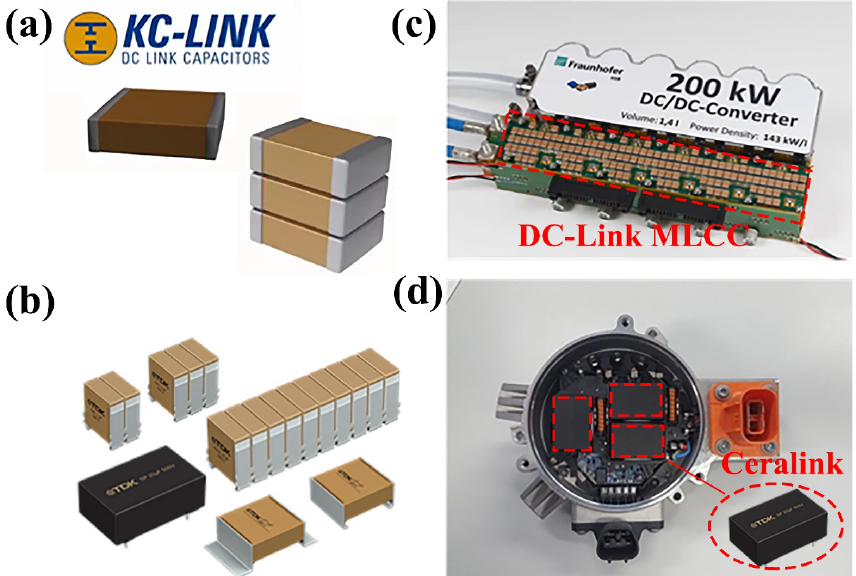
Fig. 38 (a) KEMET KC-LINK series DC-Link MLCCs [159]; (b) TDK Ceralink series DC-Link MLCCs [160]; (c) a high- power-density 200 kW DC–DC converter by Fraunhofer based on full DC-Link MLCCs and third-generation SiC MOSFETs [161]; and (d) a compact cooling pump power converter by AB Mikroelektronik GmbH for electric vehicles based on